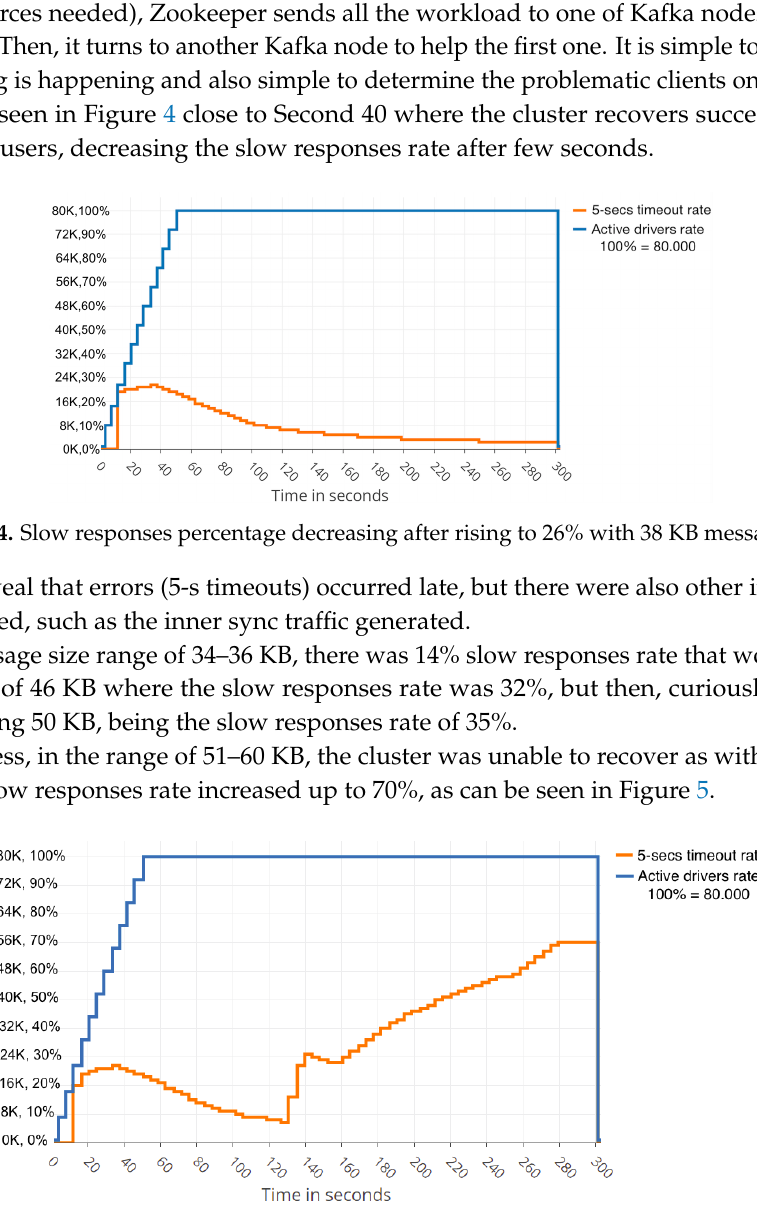
Figure 5. Slow responses first decreases, and then increases up to 70% with 58 KB message